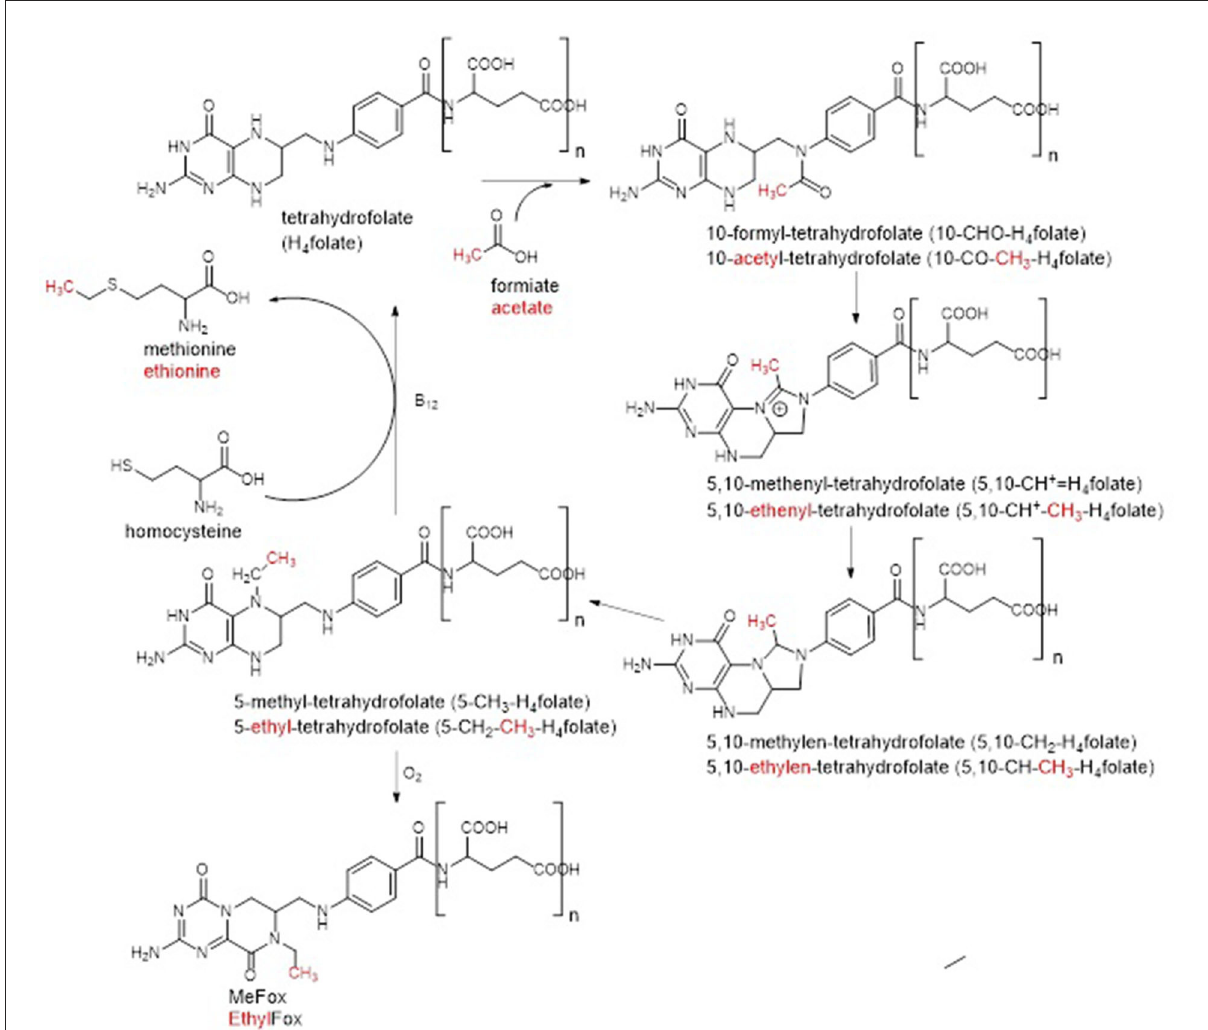
FIGURE6 Postulation of a C 2 -metabolism in Baker’s yeast by adaptation of the C 1 -metabolism. Adaptations are highlighted in